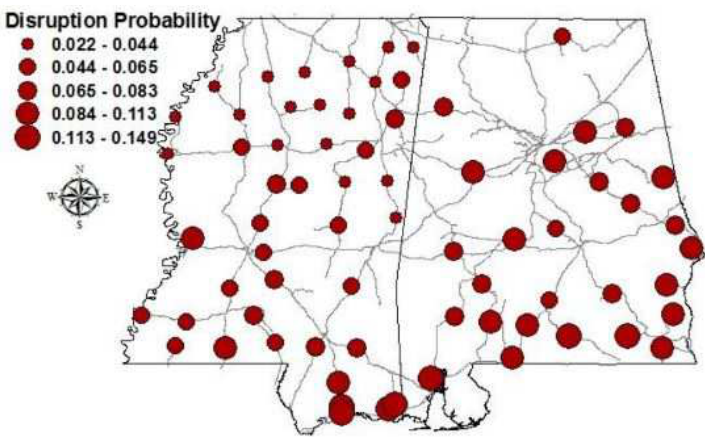
Figure 4. Disruption probability of multi-modal facilities [46].